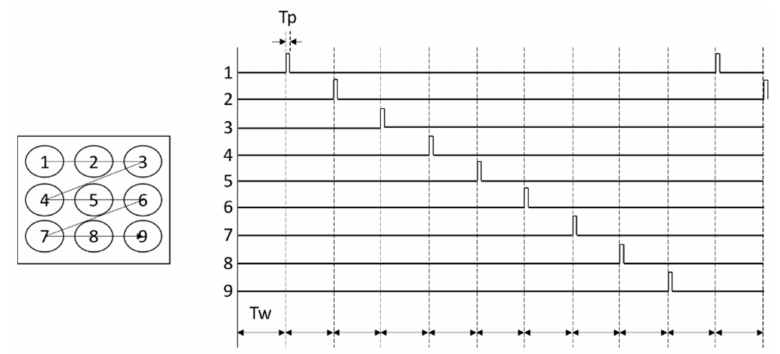
Figure 2. The pulse dust collection